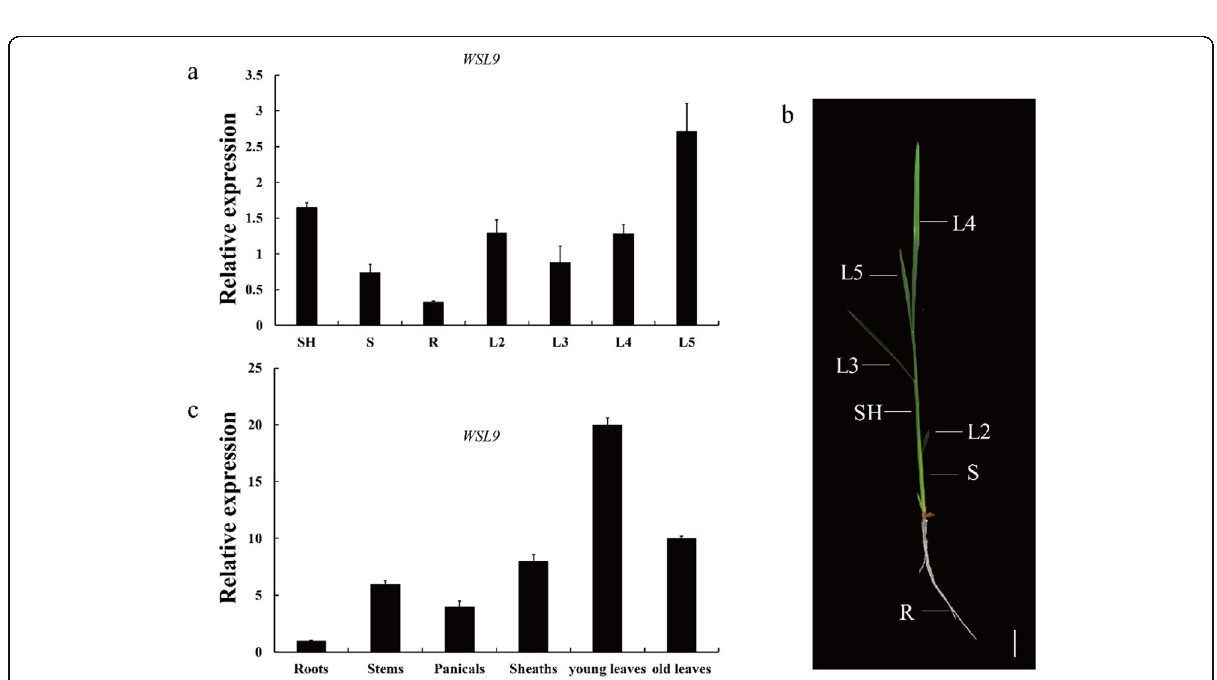
Fig. 5 Expression pattern analysis of WSL9. a qRT-PCR analysis of WSL9 transcripts in the SH, S, R, L2, L3, L4, L5 of wild-type seedlings. Wild-type plants at the five-leaf stage were used for expression analysis. L2 – L5 indicate the second to fifth leaves. R, root; S, stem; SH, a 4 cm piece from the bottom of the shoot. b Rice seedling with fully expanded fifth leaf. Scale bar, 2 cm. c qRT-PCR analysis of WSL9 transcripts after